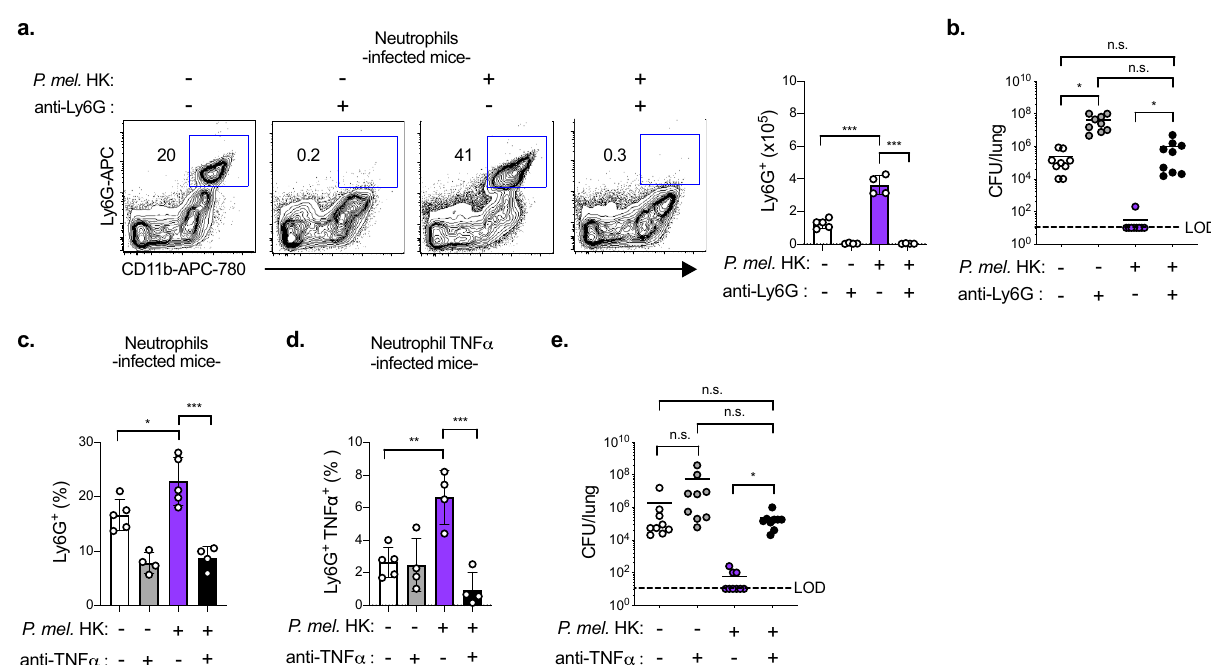
Fig. 3 Neutrophils and TNF α are critical for P. melaninogenica ( P. mel .)-mediated protection against S. pneumoniae infection. a , b Representative fl ow cytometry plots and total cell numbers for neutrophils detected by fl ow cytometry ( n = 5 mice/group, PBS, n = 4 mice/group, others) ( a ) and lung burdens of type 2 S. pneumoniae ( n = 9 mice/group) ( b ) in mice treated with isotype control or anti-Ly6G antibodies (200 μ g/mouse) i.p. together with either PBS (-) or P. mel . strain 25845 heat-killed (HK) i.t. prior to 24 h S. pneumoniae infection, 5×10 6 CFU/mouse. c – e Total cell number of neutrophils and neutrophil TNF α detected by intracellular fl ow cytometry ( n = 5 mice/group for isotype control groups, 4 mice/group for anti-TNF α groups) ( c , d ) and lung S. pneumoniae burdens ( n = 9 mice/group) ( e ) in mice treated with isotype control or anti-TNF α antibodies (200 μ g/mouse) i.p. together with either PBS (-) or P. mel . HK i.t. prior to 24 h S. pneumoniae infection. LOD = limit of detection. Data are pooled from three independent experiments ( b , e ) or representative from one of four independent experiments ( a , c , d ), displayed as mean ± SEM. For a * **p < 0.0001, one-way ANOVA with Sidak ’ s post hoc test, b from left to right * p = 0.0222, p > 0.9999, p = 0.0751, * p = 0.0192, Kruskal – Wallis with Dunn ’ s post hoc test, c from left to right * p =